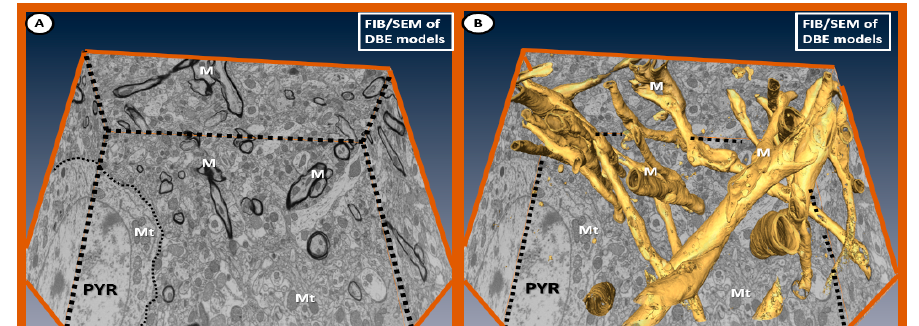
Figure 11. Fixed images of the focused ion-beam (FIB)/SEM emphasizing ultrastructural normal myelin in relation to the surrounding neuropil in DBE. Panel ( A ) depicts the markedly electron-dense myelin (M), and note that the mitochondria (Mt) are electron dense without any abnormal remodeling changes of aberrant Mt as found in DBC in prior images (especially Figures 3, 4). This 2D type of image with left and right sides folded up at the regions of the black-dashed lines illustrates the marked electron density of myelin allowing the computer to stack and create 3D images in panel ( B ). Note the large pyramidal (PYR) cell with electron-dense, normal appearing cytoplasmic mitochondria in both panels ( A ) and ( B ) within the cytoplasm of PYR cells. Importantly, there is no splitting, separation or disarray as noted in previously-fixed ultrastructural DBC images. Panel ( B ) illustrates the computerized developed 3D-type image of myelin as a result of stacking electron dense myelin, which allowed the computer program to pseudo-color myelin golden. Note the uniformity of the golden myelin without separation, splitting or disarray as compared to the previous DBC figure images. There are marked differences in the morphology of DBC aberrant Mt within microglia cell and other glia and mural cells (EC and Pc) in capillary NVUs (Figure 5). Also, there appears to be no aMt and the myelin remains intact without splitting or separation in the EMPA treated models. We have made a direct side-by-side comparison on the pre-run fixed images for FIB/SEM between DBC untreated and treated DBC with EMPA-treated DBE (Figure 12).